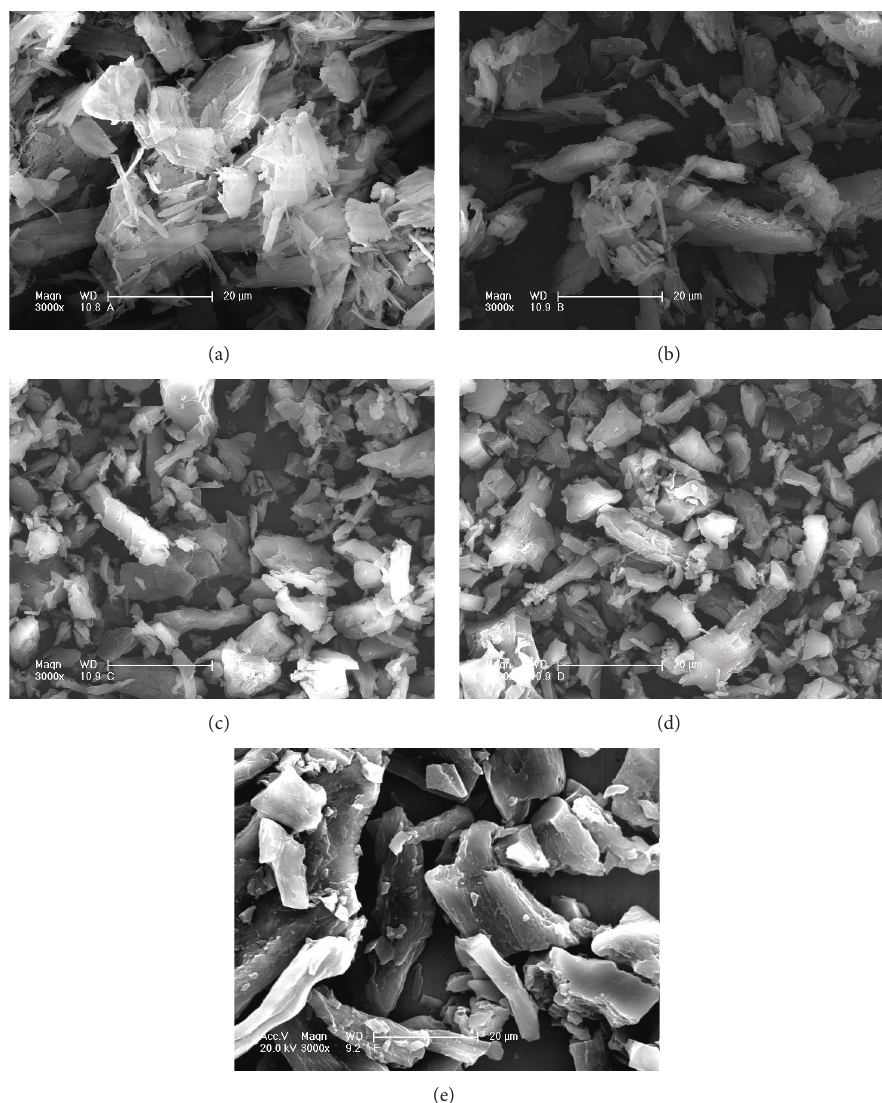
Figure 6: SEM micrographs ( × 3,000) of the heat-treated cellulose particles. (a) Cel 00 . (b) Cel 30. (c) Cel 35 . (d) Cel 40. (e) Cel 40/120